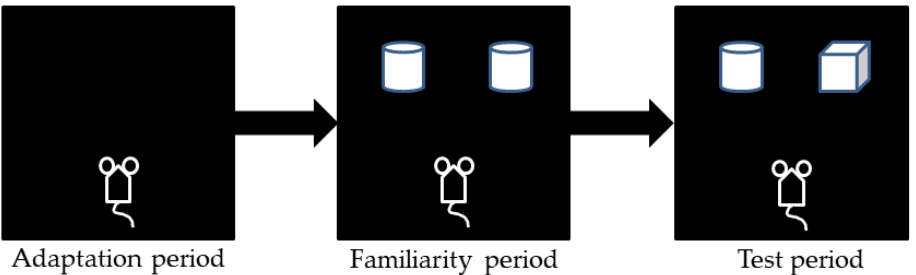
Figure 2. Novel object recognition test experimental procedure in sham control group ( n = 10) and model group ( n = 12).